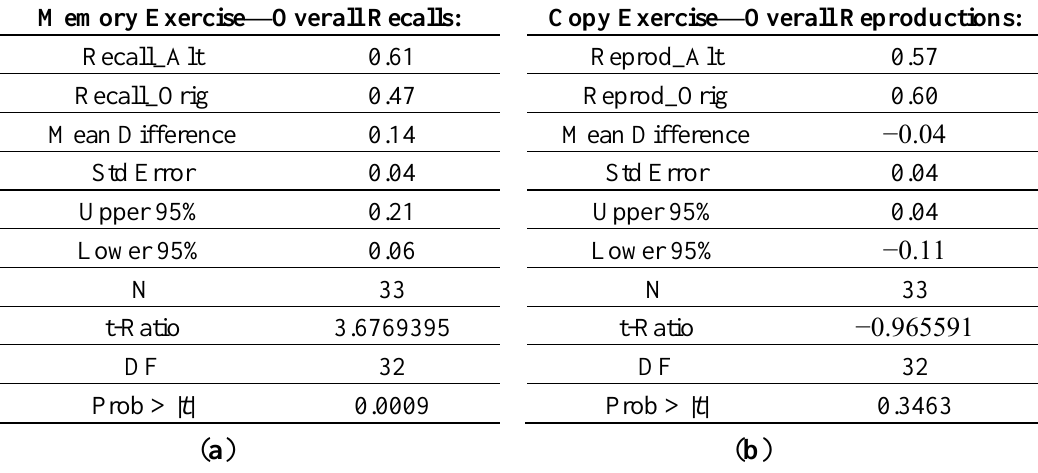
Table 1. Matched Pairs Comparison: ( a ) Memory Exercise: Overall recalls in Original versus Altered Drawings; ( b ) Copy Exercise: Overall reproductions in Original versus Altered